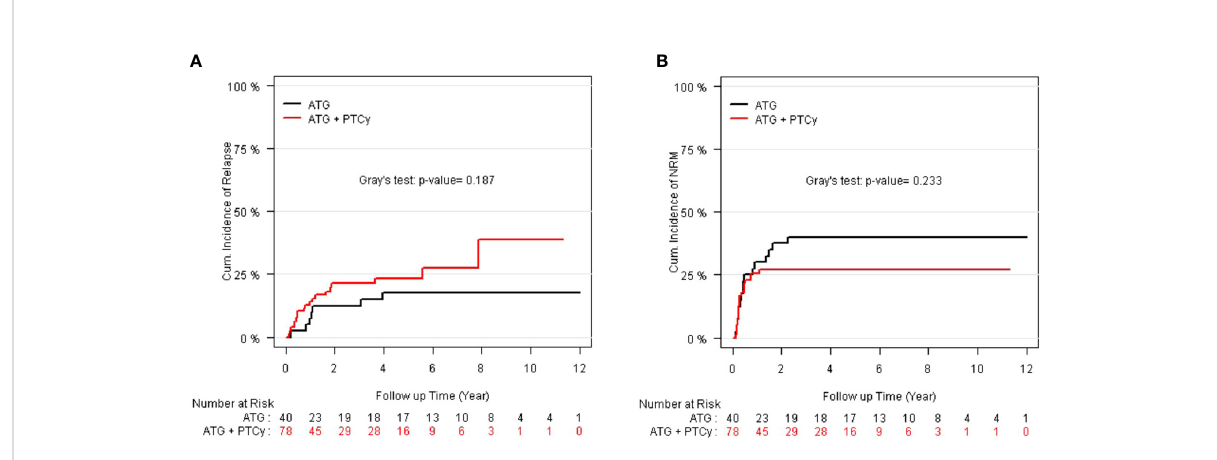
FIGURE 3 CI of relapse and non-relapse mortality (NRM) according to treatment groups: (A) CI of relapse; (B) CI of